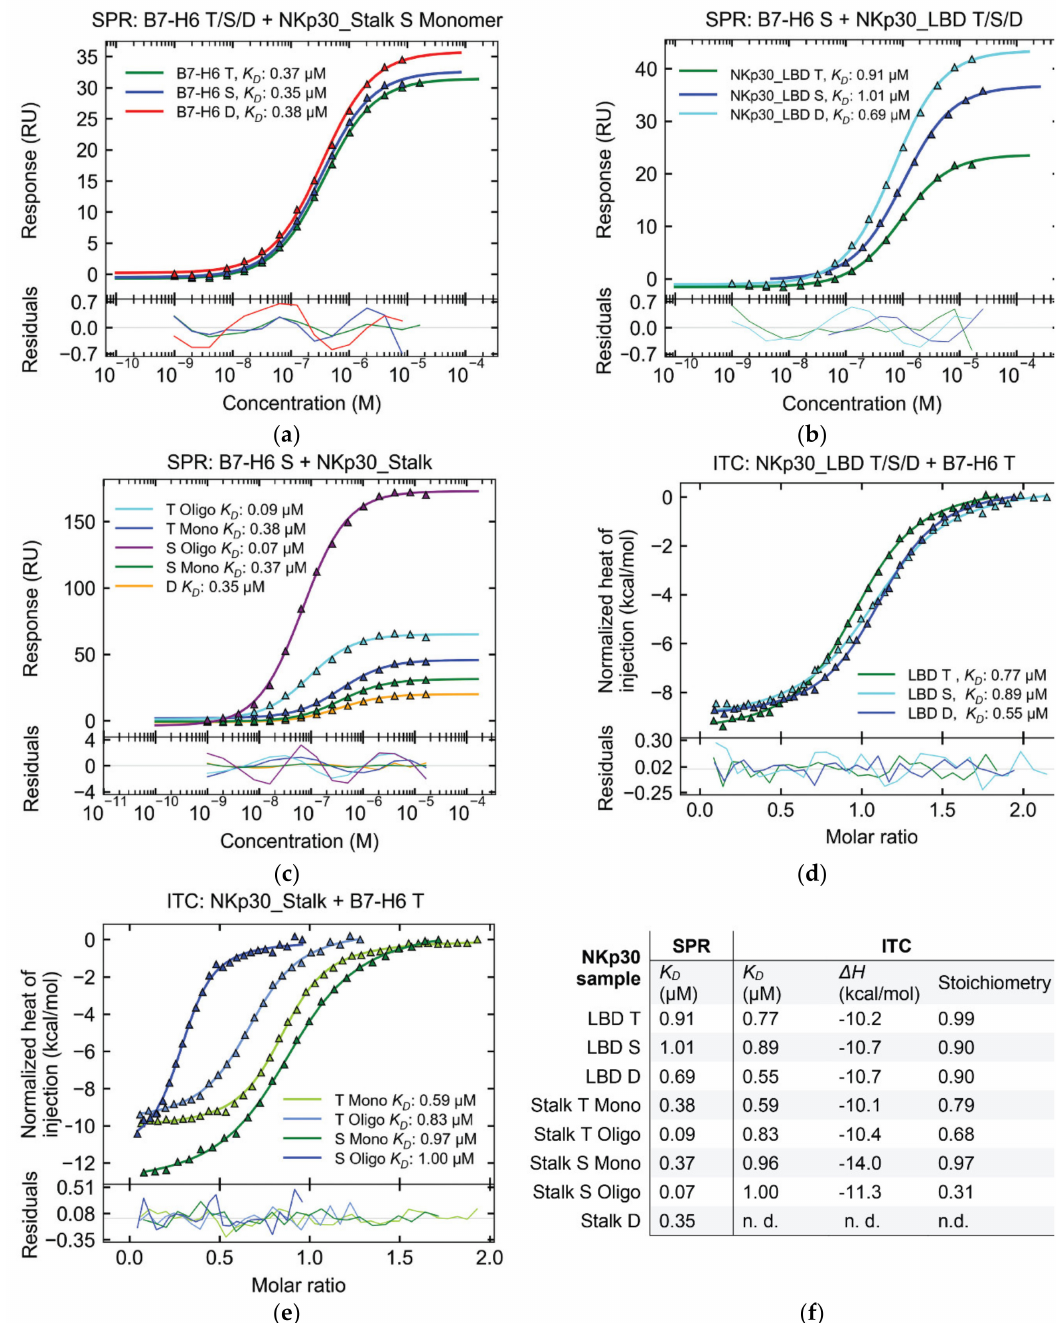
Figure7. CharacterizationoftheNKp30:B7-H6interactionbySPRandITC.Typeofproteinglycosylation: T—wild-type, S—uniform, D—deglycosylated, Mono—monomeric, Oligo—oligomeric fraction of NKp30_Stalk. Titles above individual graphs describe the given experiment: SPR or ITC, protein bound to SPR sensor or present in ITC cell + protein flown over the sensor or titrated into the cell, respectively. interaction with B7-H6. ( c , e ) Stalk region and oligomerization of NKp30 enhance its a ffi nity to B7-H6 in SPR but not in ITC. ( f ) Comparison of all thermodynamic parameters measured for the NKp30:B7-H6 interaction with di ff erent protein